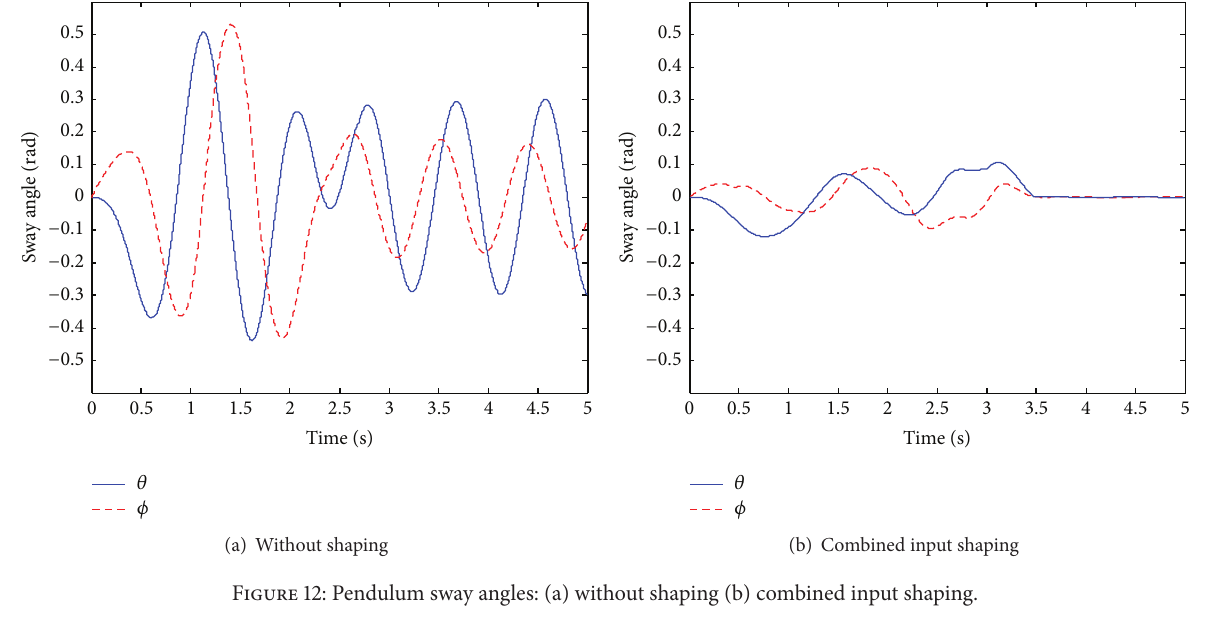
Figure 12: Pendulum sway angles: (a) without shaping (b) combined input shaping.